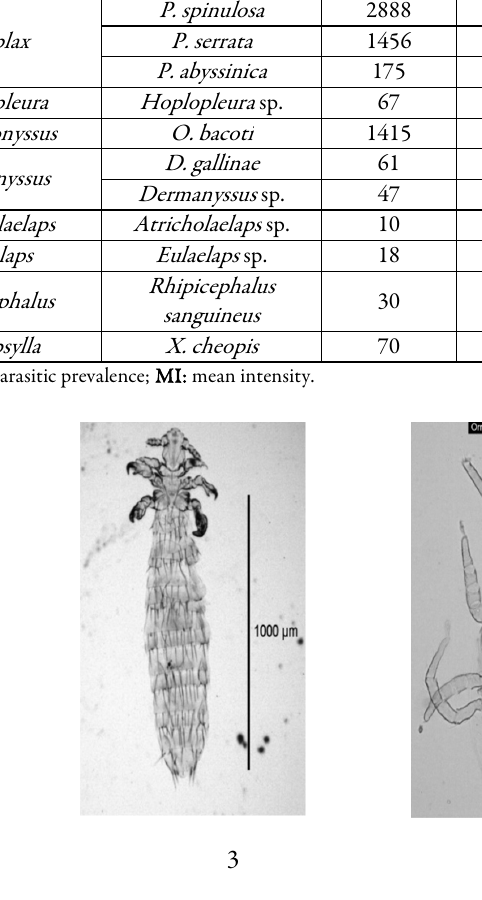
Table 1. Ectoparasites species collected from R. rattus caught in palm groves of Touggourt Family Genus Species N Pr (%)